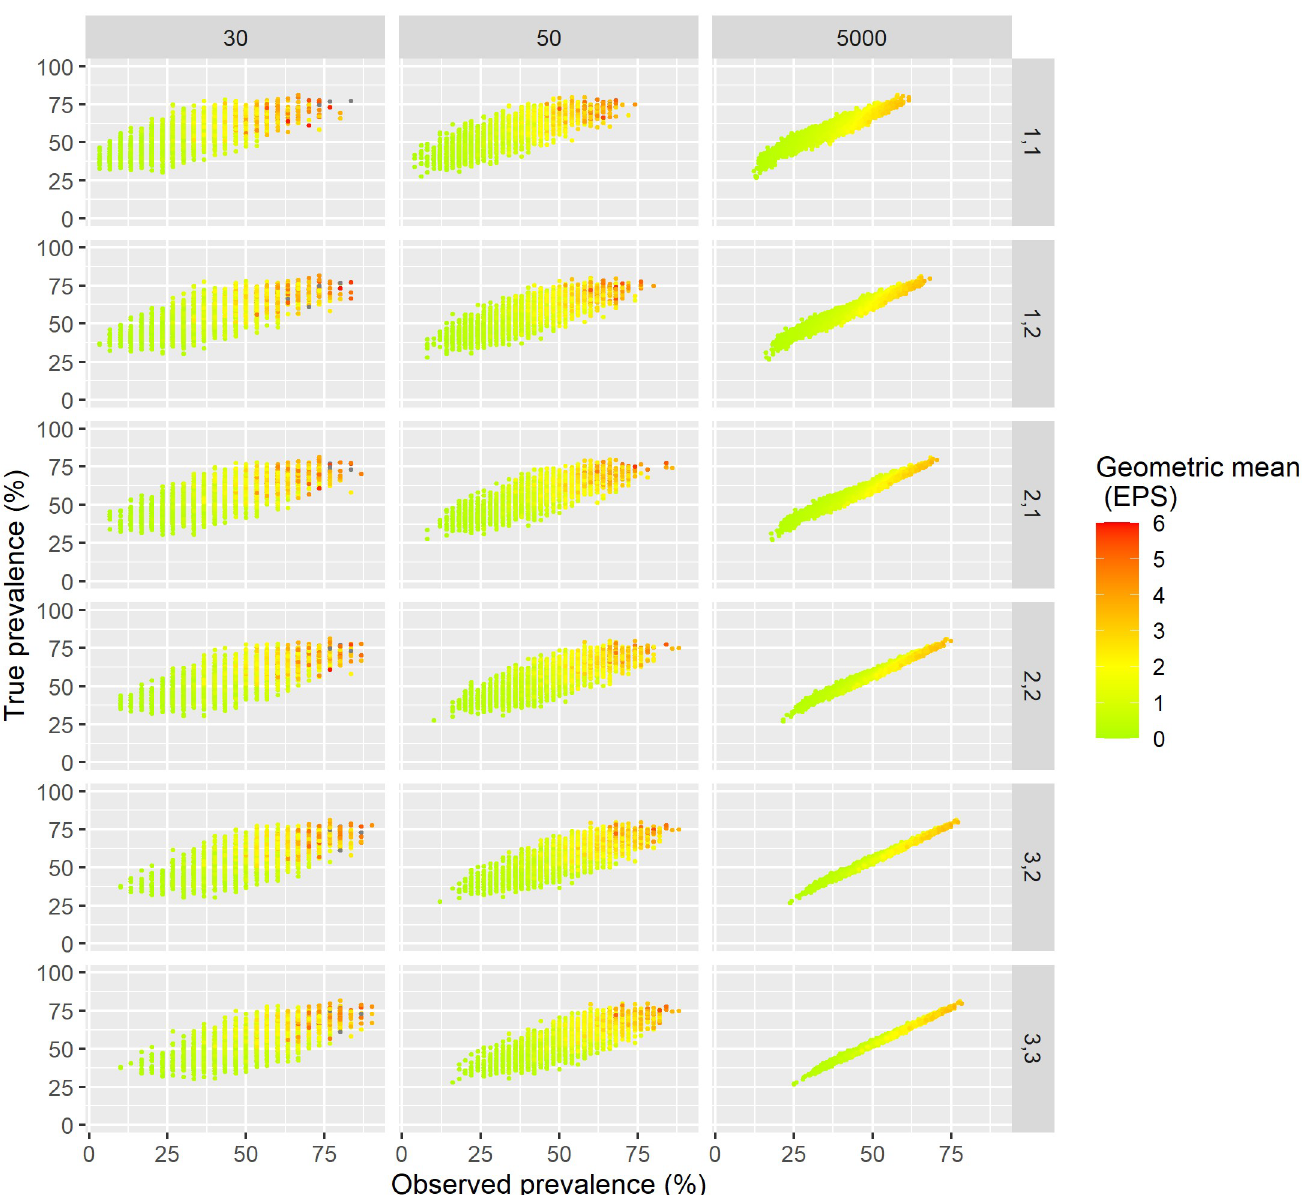
Fig 2. Relation between observed prevalence and ‘true’ prevalence for sample sizes of 30, 50, and 5,000 with geometric mean of the total population in color. The sampling scheme applied is denoted on the right hand side where the first number is the number of stool samples and the second the number of slides per day. The geometric mean infection intensity is shown in color and EPS refers to